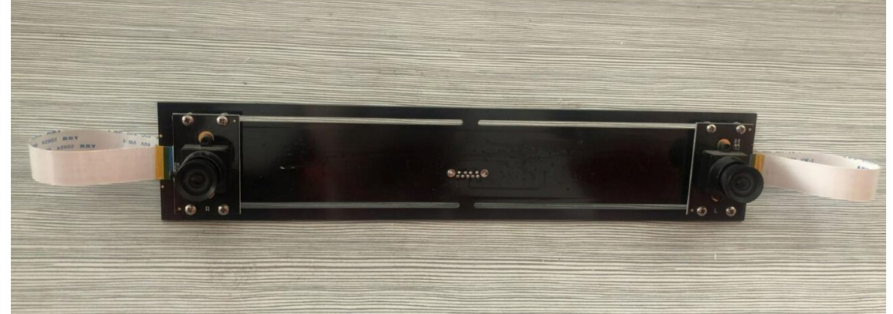
Figure 8. Parallel structure of the binocular